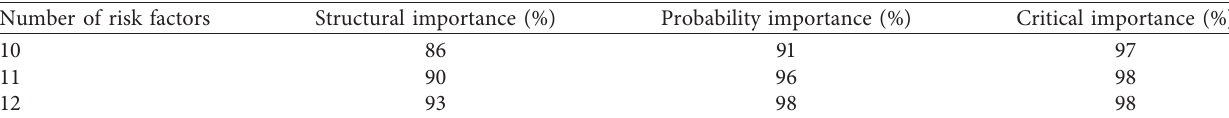
Table 2: The cumulative sum of the normalized index.